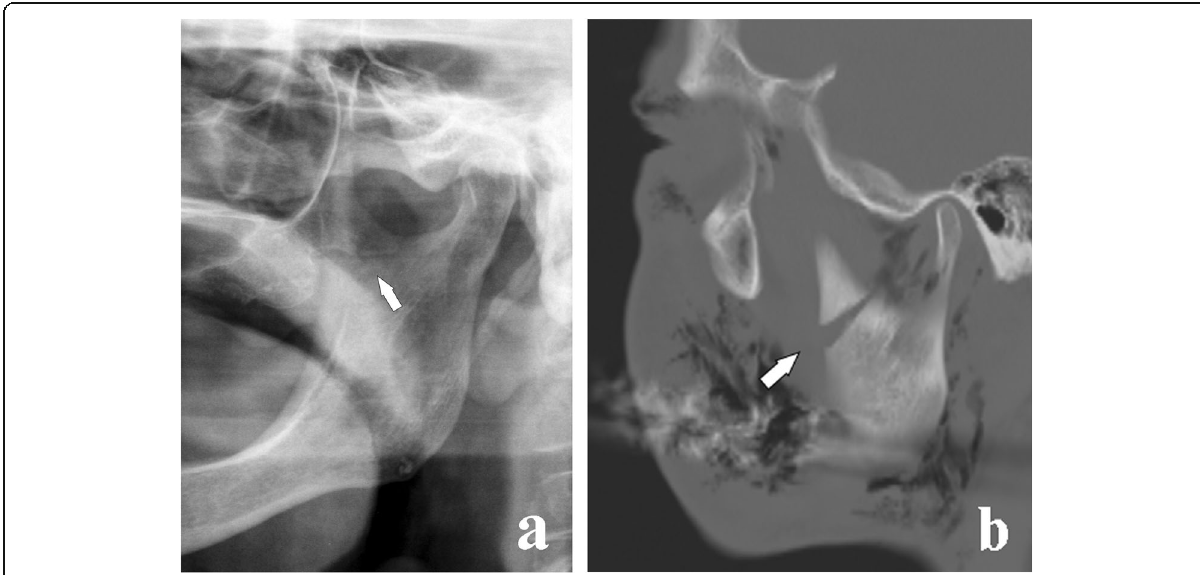
Fig. 10 Coronoid process fracture medial to the deepest central point of the sigmoid notch. a Cropped panoramic radiograph in a toothless patient. The fracture rhyme (arrow) originates from the internal face of the coronoid process and ends medially to the deepest central point of the sigmoid notch. b Computed tomography 5-mm oblique reconstruction of a different patient who underwent the examination following a road accident. The displacement of the bone fragment is remarkable